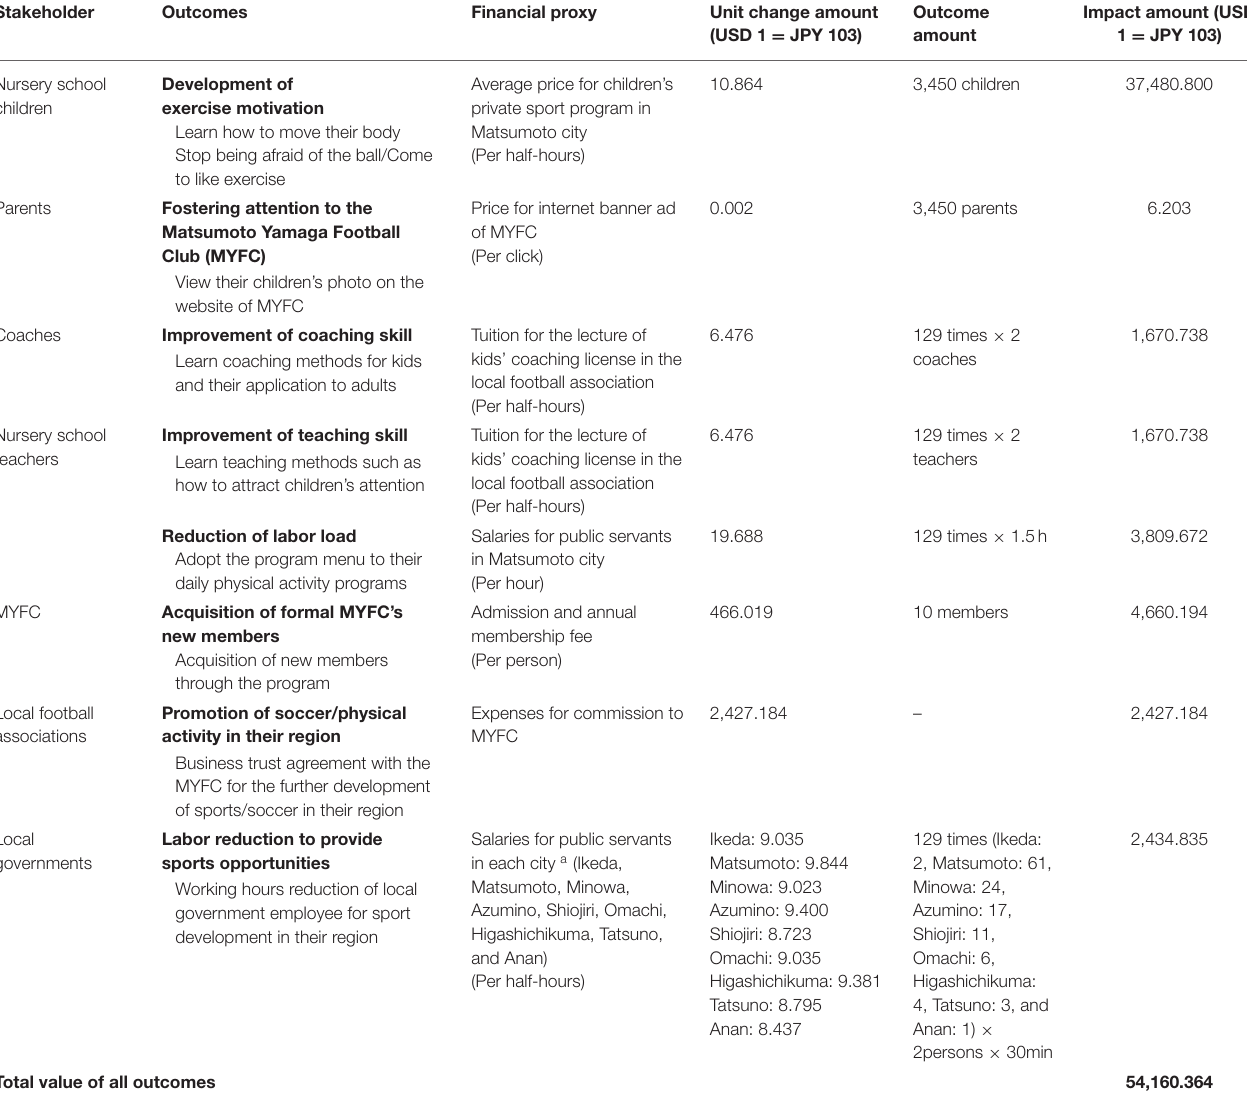
TABLE 1 | Results of social return on investment